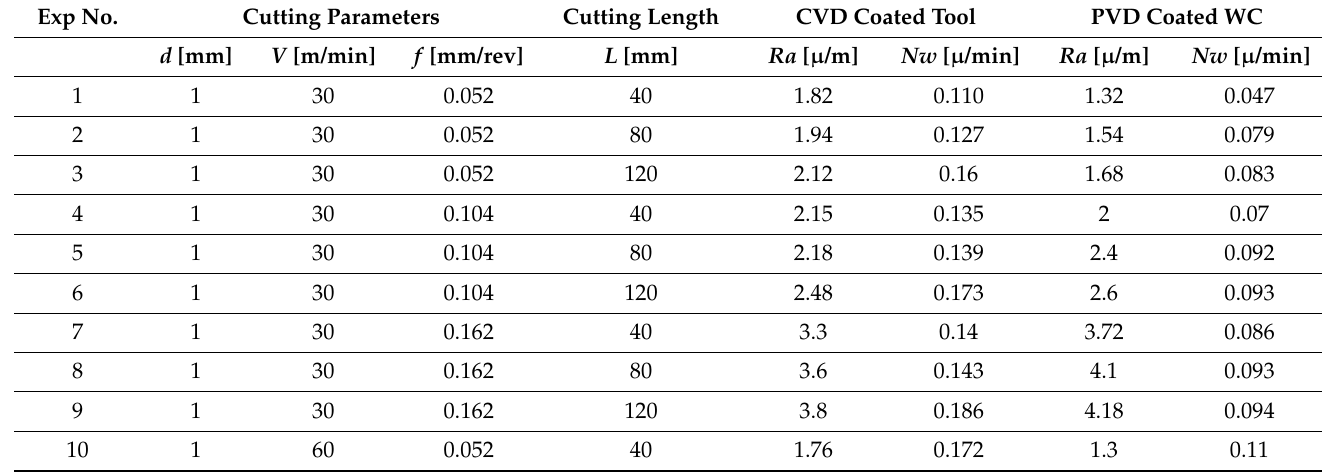
Table A1. Training data of various cutting parameters to train the SVM model [5]. Exp